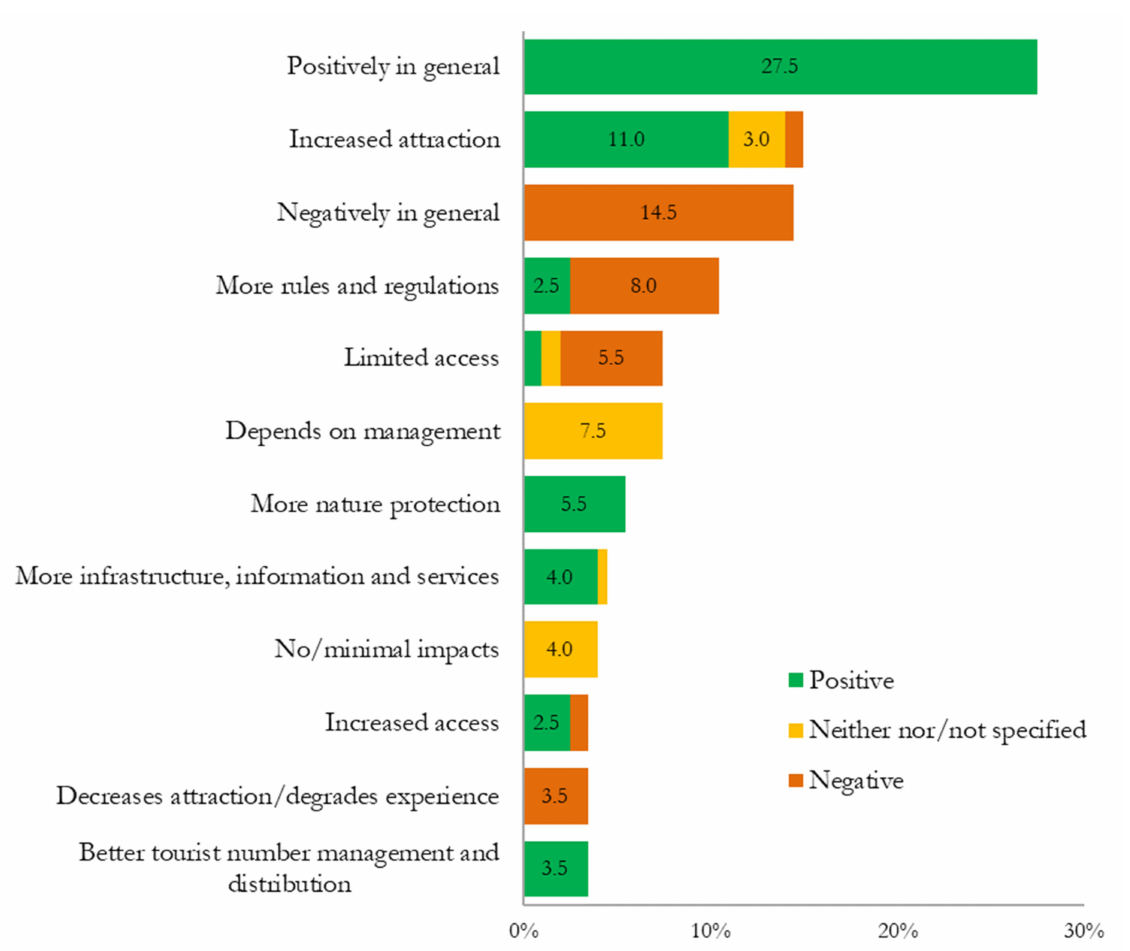
Figure 7. The tourism companies’ evaluation of the impacts of establishing the Central Highlands National Park on the tourism industry.